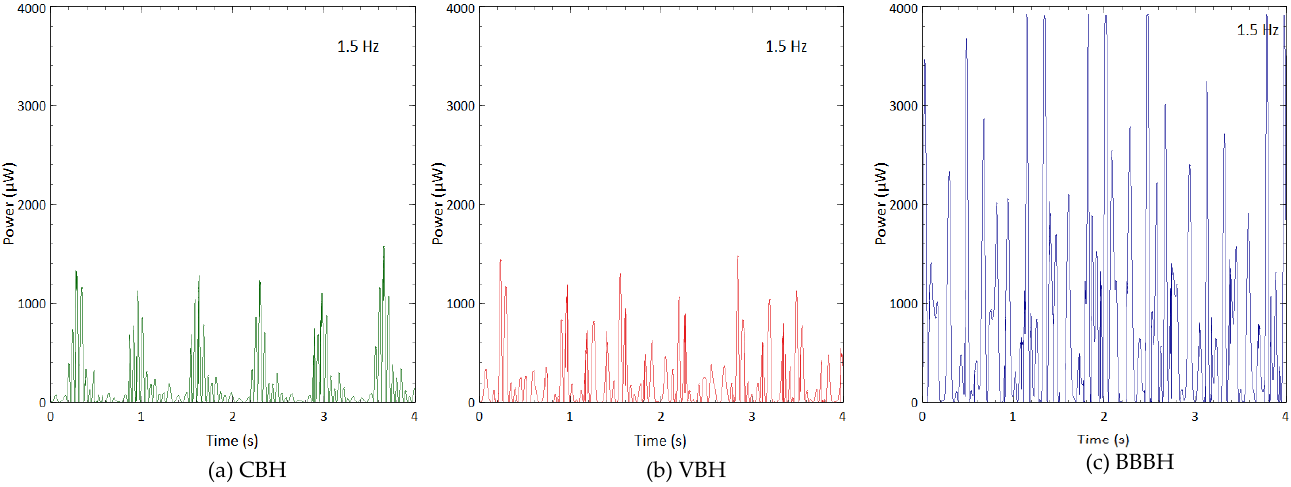
Figure 14. Power generated by ( a ) CBH, ( b ) VBH, and ( c ) BBBH for human walking (1 Hz).